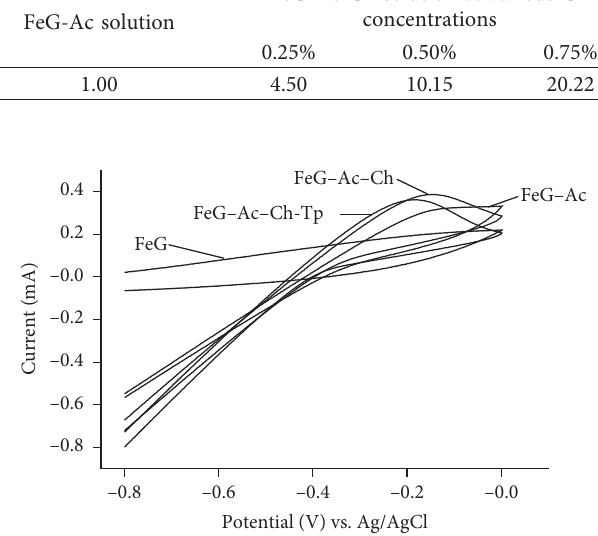
Figure 5: Cyclic voltammogram of complex solutions containing FeG 10mM, Ac 2.5%, Ch 0.5%, and Tp 0.25% during iron mi- croparticle